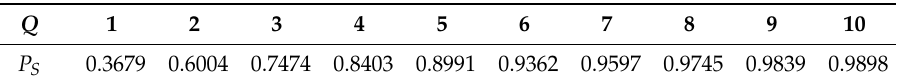
Table 2. Success Probability at the Saturation Threshold under Different Transmission